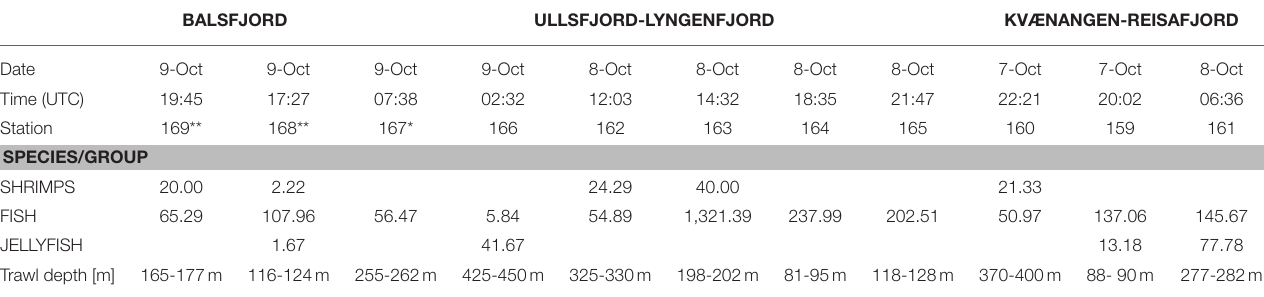
TABLE 1 | Overview of bottom trawl catches (kg · nmi − 1 ) in Lyngen and adjacent fjords, conducted by RV Håkon Mosby within the region of Figure 1 , 7–9 October